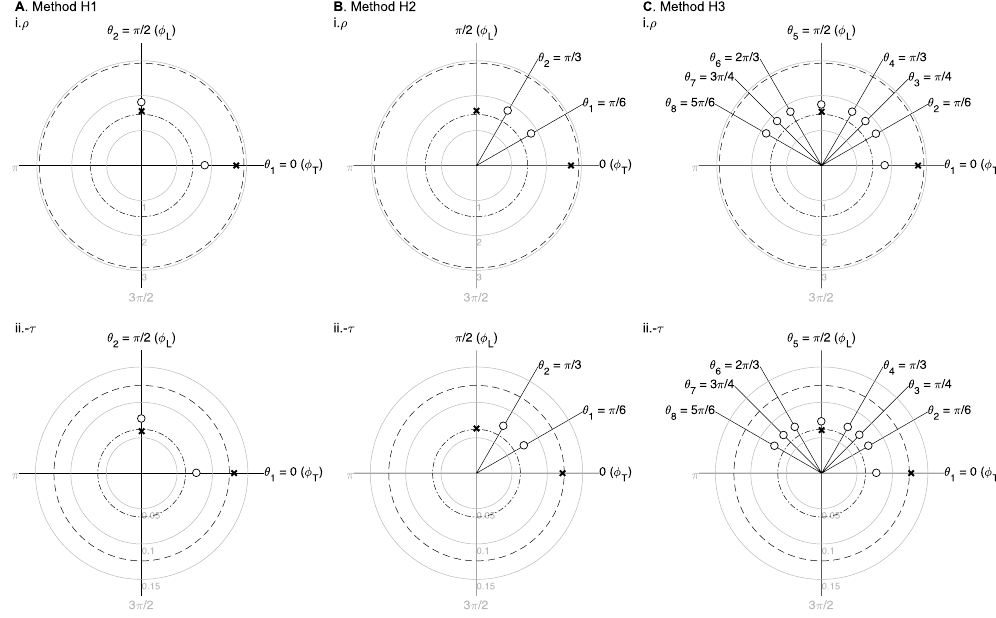
Figure 1. Numerical simulation results using methods H1 ( A ), H2 ( B ), and H3 ( C ). The estimated impedivity in κ (shown in crosses) were calculated from M = 10 averaged longitudinal (L) and transverse (T) directions L { ,T} ˆ κ θ ˆ measurements (shown in circles), with d = 1, … , D the measurement angles and inter- apparent impedivity ( ) d a electrodes’ distance p = 8.6. Method H1 ( D = 2): ˆ